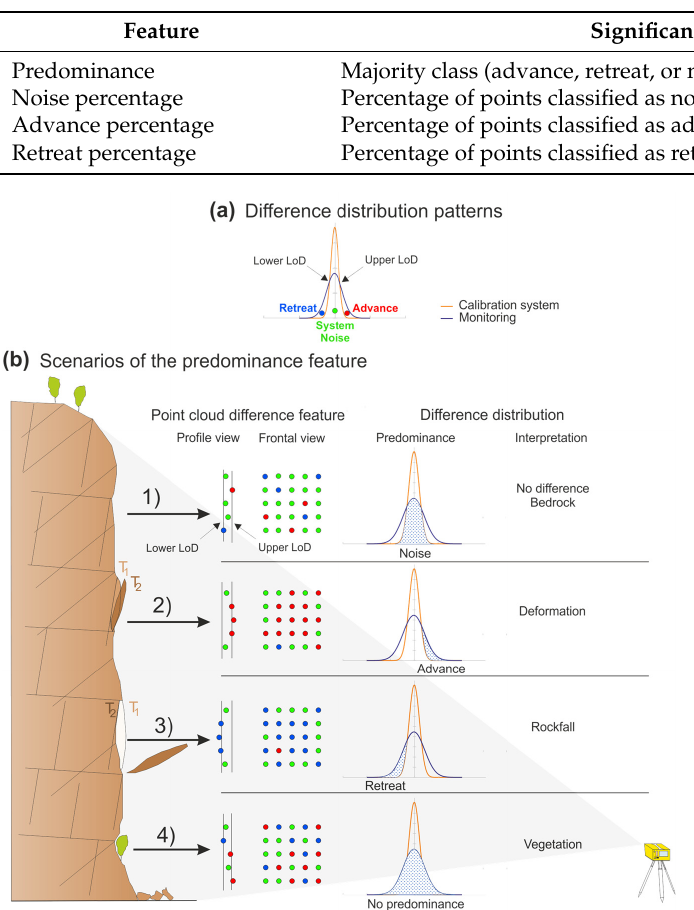
Figure 4. ( a ) Reference distribution of the differences between the calibration system and moni- toring. ( b ) Possible scenarios during the monitoring of a rock cliff and its interpretation in the